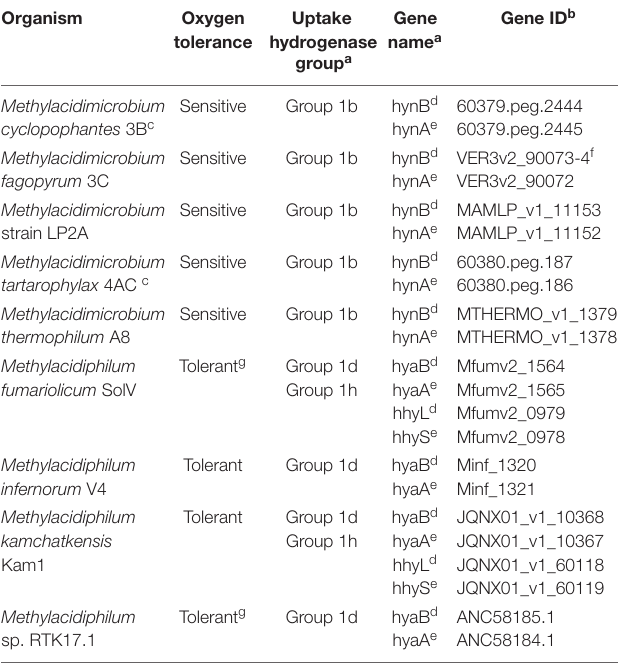
TABLE 2 | The [NiFe] H 2 -uptake hydrogenases of acidophilic verrucomicrobial